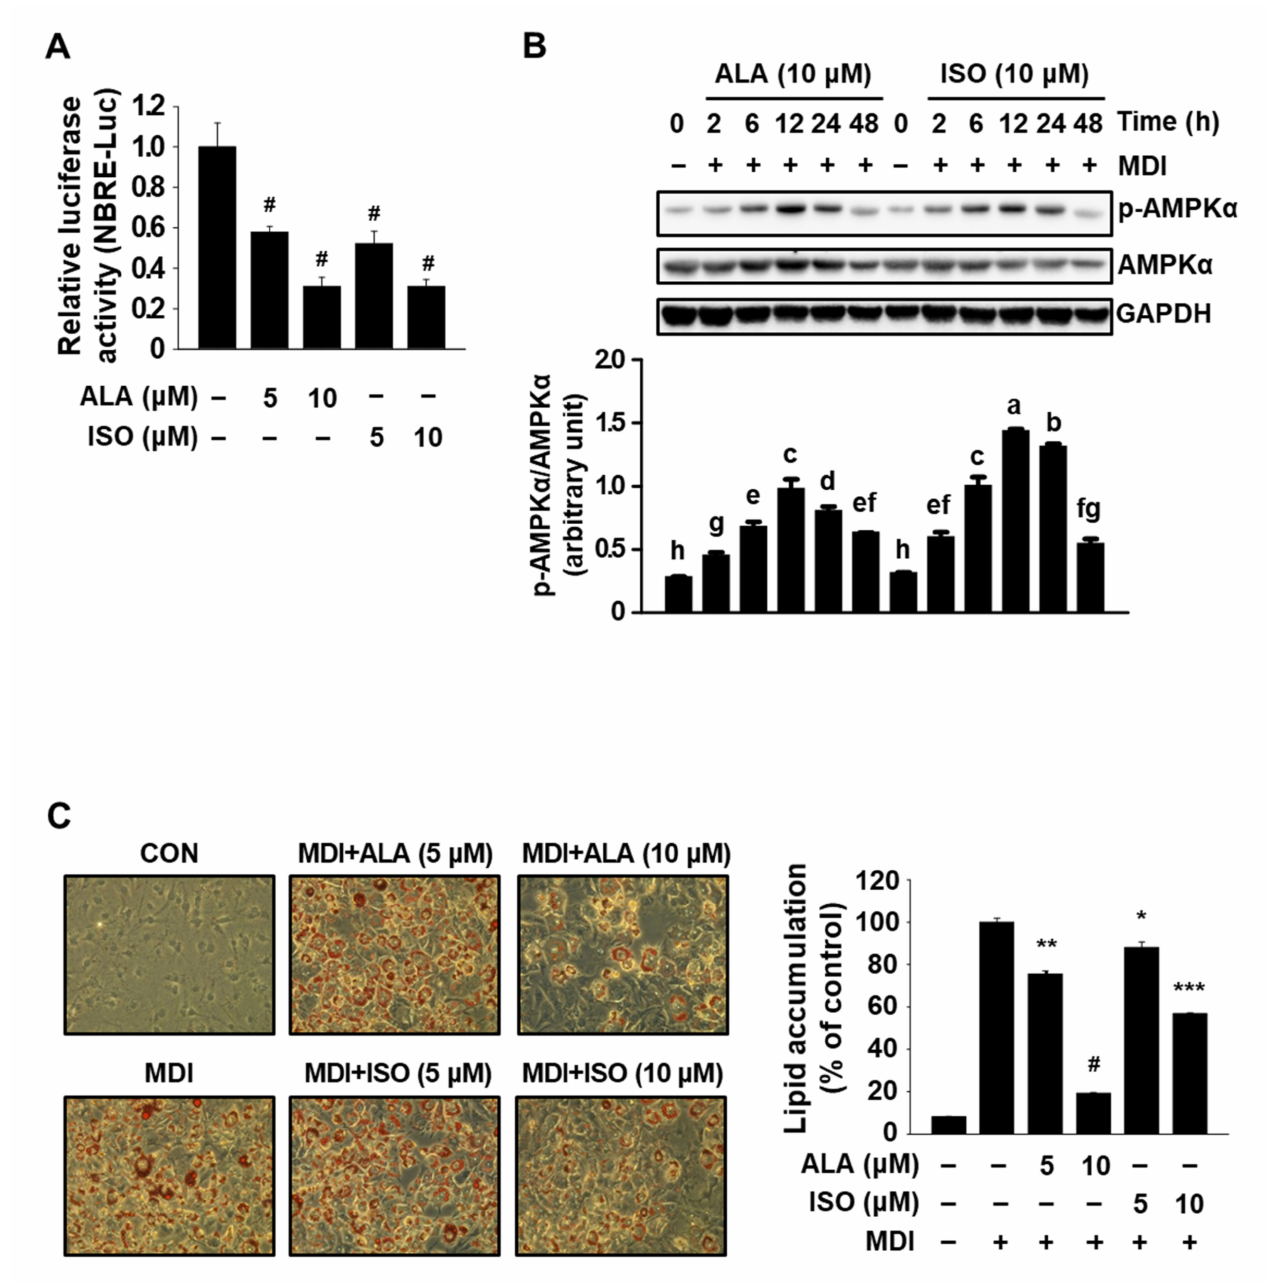
Figure 1. ALA and ISO simultaneously regulate Nur77 and AMPK α and inhibit the MDI-induced adipogenic differentiation of 3T3-L1 cells. ( A ) MiaPaCa-2 cells were cotransfected with Flag-Nur77 (12.5 ng) and NBRE-Luc (25 ng) for 4 h and then treated with ISO and ALA for 18 h. Luciferase activity (relative to β -galactosidase) was then determined; # p < 0.001 vs. DMSO + Nur77. ( B ) 3T3-L1 cells were treated with each compound in the presence of MDI for the indicated time period and whole cell lysates were analyzed by Western blot analysis. Different letters indicate a significant difference at p < 0.05. ( C ) 3T3-L1 cells were treated with each compound in the presence of MDI for 7 days and intracellular lipid accumulation was measured; * p < 0.05, ** p < 0.01, *** p < 0.005, and # p < 0.001 vs. MDI